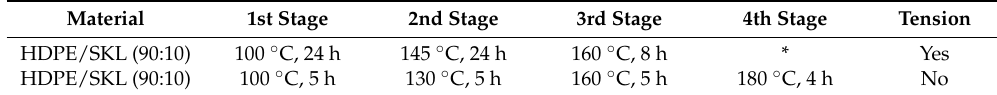
Table 6. Thermal stabilization experiments under